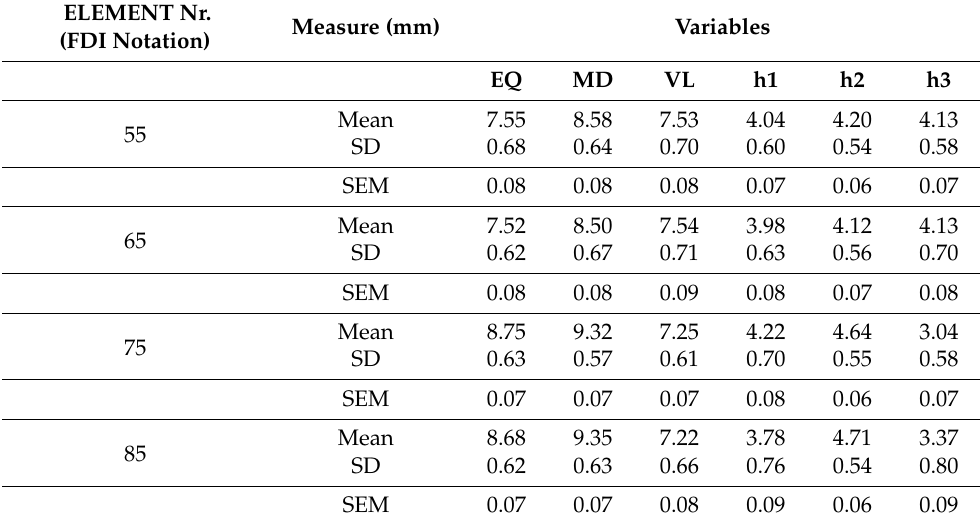
Table 1. Descriptive analysis of data.